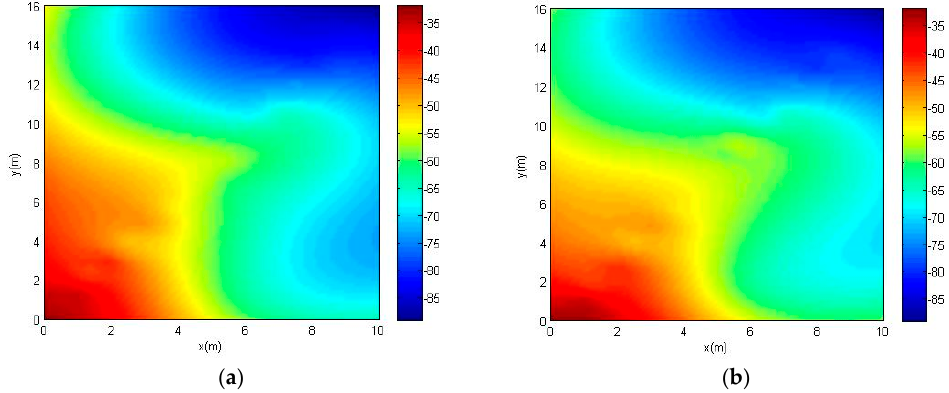
Figure 1. Fingerprint heat maps of one access point (AP; Media Access Control (MAC): B8-F8-83-CF-F8-96) on two different days. ( a ) 27 September 2017; ( b ) 27 October 2017.